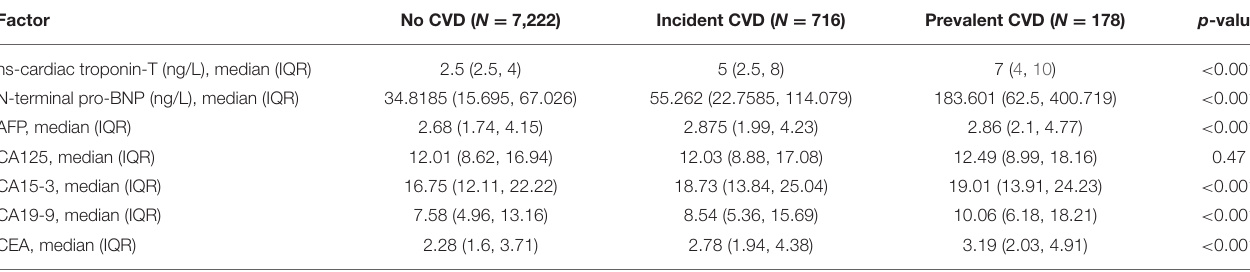
TABLE 3 | Cardiac and tumour biomarker levels in patients without and with CVD.